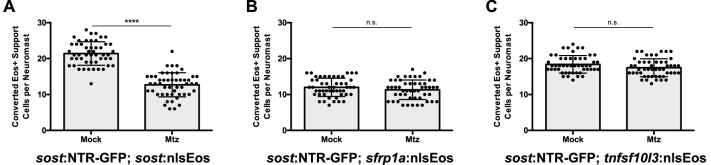
Ablation of DV cells does not decrease the number of other support cell populations.(A) Total number of sost:nlsEos-positive support cells per neuromast following DV cell regeneration. Mock: 21.42 ± 3.29, n = 50 neuromasts (10 fish); Mtz: 12.70 ± 3.35, n = 50 neuromasts (10 fish); mean ± SD; Mann Whitney U test, p<0.0001. (B) Total number of sfrp1a:nlsEos-positive support cells per neuromast following DV cell regeneration. Mock: 12.00 ± 2.54, n = 50 neuromasts (10 fish); Mtz: 11.32 ± 2.71, n = 50 neuromasts (10 fish); mean ± SD; Mann Whitney U test, p=0.2413. (C) Total number of tnfsf10l3:nlsEos-positive support cells per neuromast following DV cell regeneration. Mock: 18.40 ± 2.44, n = 50 neuromasts (10 fish); Mtz: 17.46 ± 2.49, n = 50 neuromasts (10 fish); mean ± SD; Mann Whitney U test, p=0.0699.10.7554/eLife.43736.033Figure 11—figure supplement 1—source data 1.Ablation of DV cells does not decrease the number of other support cell populations